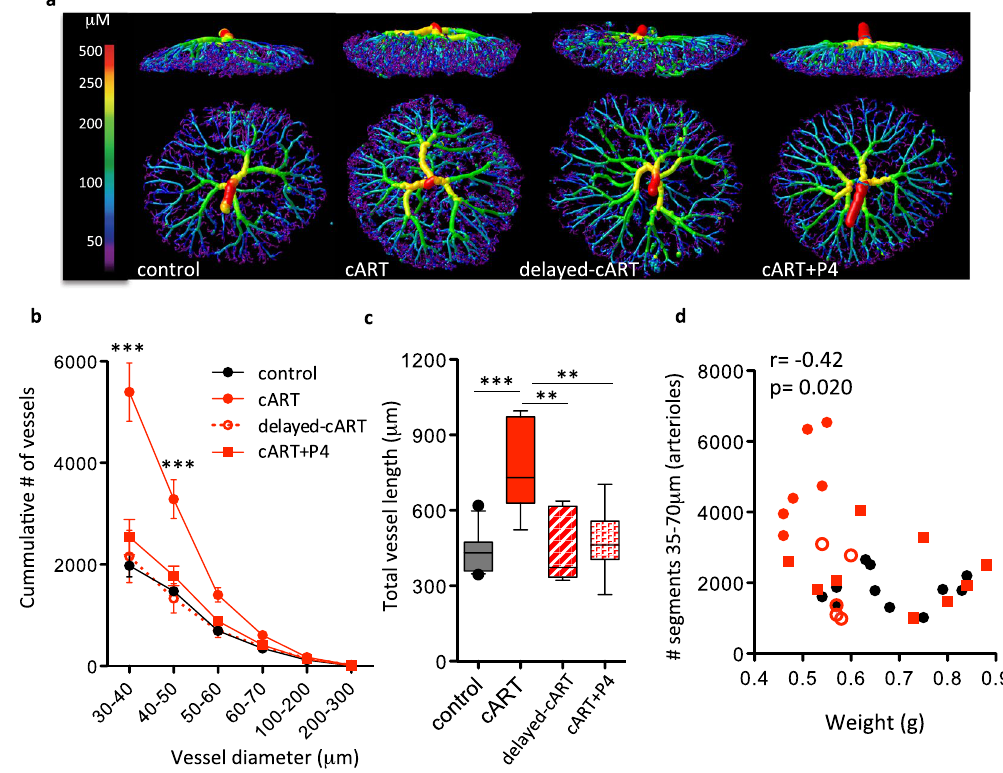
Figure 6. Delaying initiation of cART and supplementing with progesterone prevents the cART-associated placenta vascular changes. ( a ) Representative micro-CT images of GD15 feto-placental arterial vasculature colour coded by vessel diameter from mice treated with control, cART starting on GD1 (cART), cART starting on GD6 (delayed-cART), or cART starting on GD1 and supplemented with progesterone (cART + P4). ( b ) Cumulative number of feto-placental arterial vessels by vessel diameter. Lines represent the mean with SEM. Statistical comparisons by 2-way ANOVA (p < 0.0001) with Bonferroni post-test comparing all treatment groups to control. *** p < 0.001. ( c ) Total vessel length of feto-placental arterial vessels. Box plot shows the median and interquartile range with whiskers denoting the 10 th –90 th percentile, and dots the > 90 th percentile. Statistical comparisons by one-way ANOVA (p = 0.0002) with Bonferroni post-test. *** p < 0.001, ** p < 0.01. ( d ) Number of arterioles correlate with feto-placenta weight. Data from control mice are shown in black circles, from cART mice in red dots, from delayed-cART mice in open red dots, and from cART + P4 mice in red squares. Correlation assessed by Spearman test. For ( b–d ) n = 11 placentas from 5 dams for control, n = 6 placentas from 3 dams for cART, n = 5 placentas from 2 dams for delayed-cART, and n = 9 placentas from 3 dams for cART +